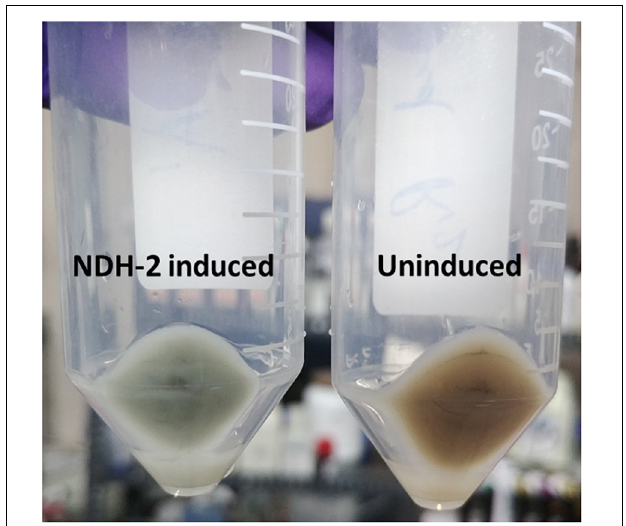
FIGURE 1 | Cell pellets of NDH-2 induced (1 mM IPTG) and uninduced cultures, Green color of the pellet is due to the presence of FAD cofactor in the NDH-2